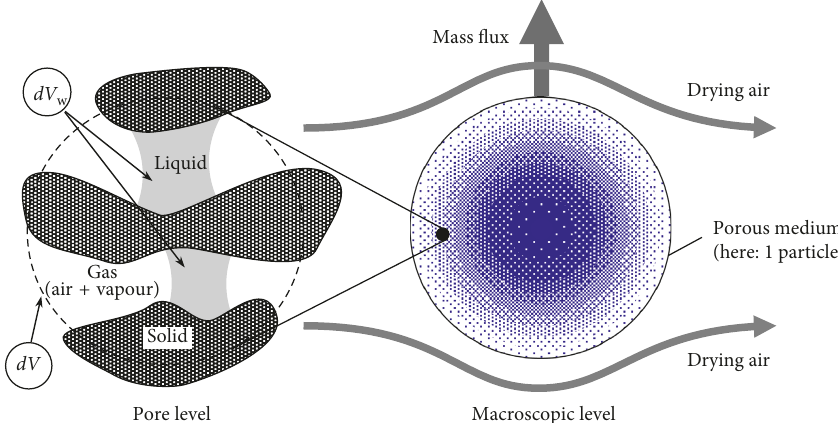
Figure 1: Modelling the drying process in porous media: pore scale (the microscopic scale) and macroscopic